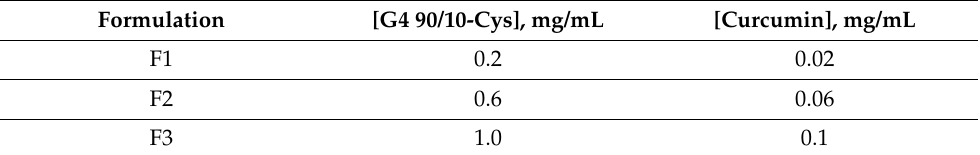
Figure 7. Release kinetics of the encapsulated curcumin: G4 90/10-Cys-Cur was placed in a dialysis tubing (3.5 kDa) and dialyzed against methanol at a constant speed. Samples of the dialysate were taken at various time intervals and their absorbance values at 425 nm were obtained. After removal of each sample of dialysate, fresh PBS was added to maintain the original volume. Table 1. G4 90/10-Cys encapsulated with varying amounts of